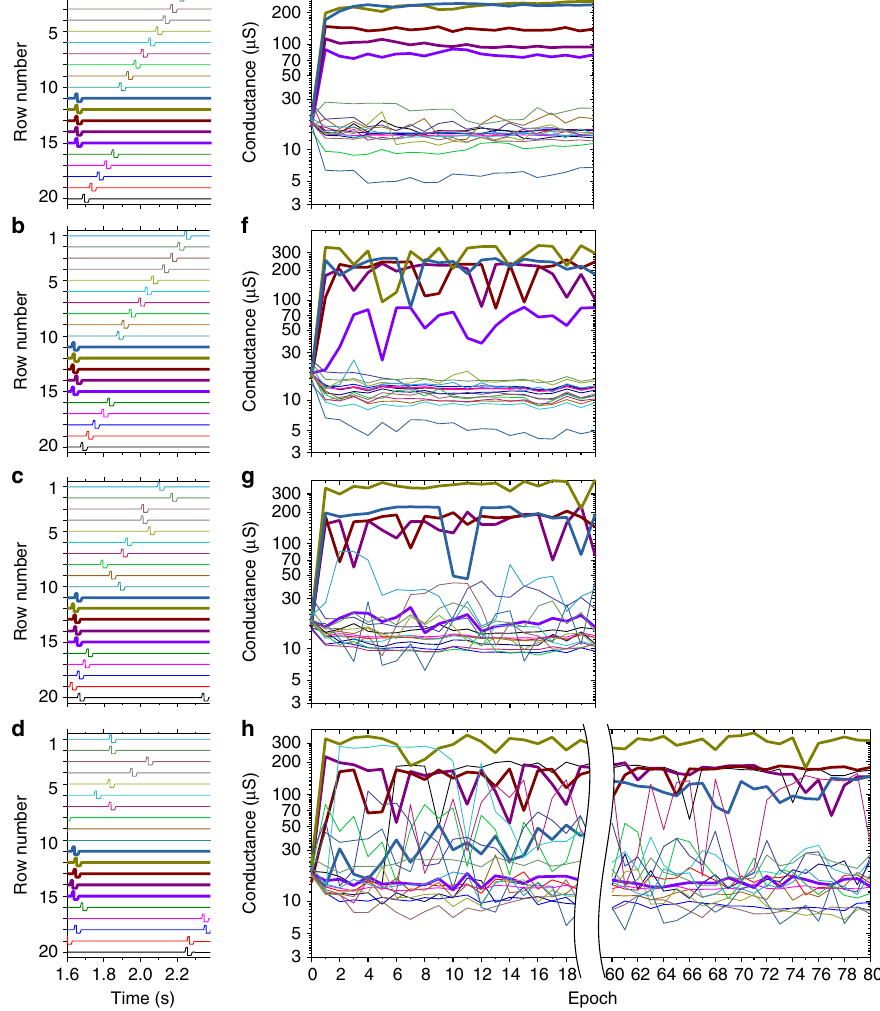
Fig. 4 Coincidence detection of higher-noise pattern. a – d Example of speci fi c spiking input frame with a ( t jitter ) max = 0, ( Δ offset ) max = 0, b ( t jitter ) max = 27 ms, ( Δ offset ) max = 27 ms, c ( t jitter ) max = 27 ms, ( Δ offset ) max = 216 ms, and d ( t jitter ) max = 27 ms, ( Δ offset ) max = 432 ms and e – h corresponding results for time evolution of all devices ’ conductances involved in the experiment. A single data point on right panels corresponds to the conductance measured at the end of a particular epoch. For all experiments, p spike = 1. All inputs and corresponding conductances are shown using unique colours. Thicker lines show synchronous